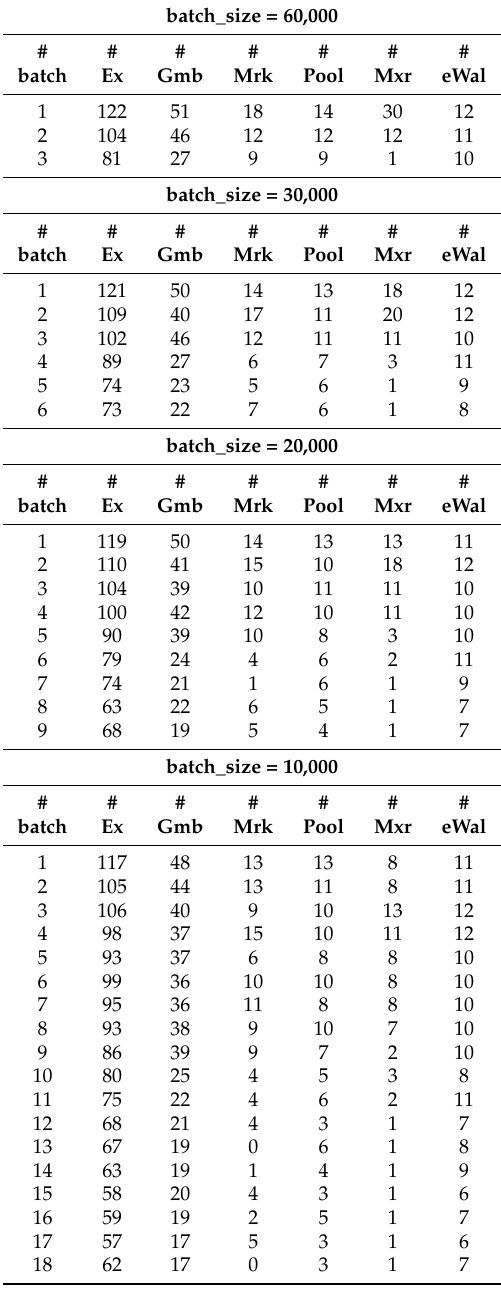
Table 2. Distinct known entities in each experiment and for each